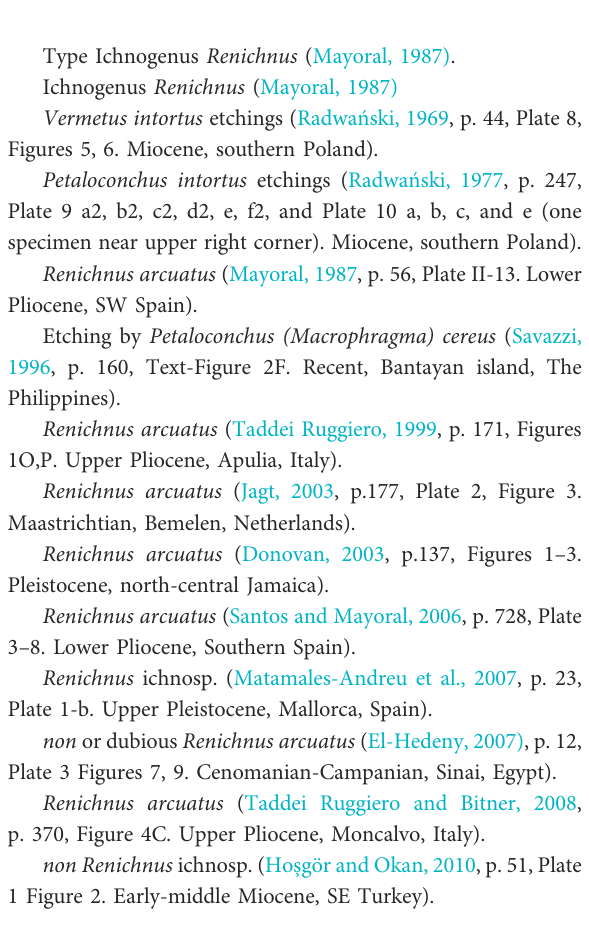
1 Figure 2. Early-middle Miocene, SE Turkey).